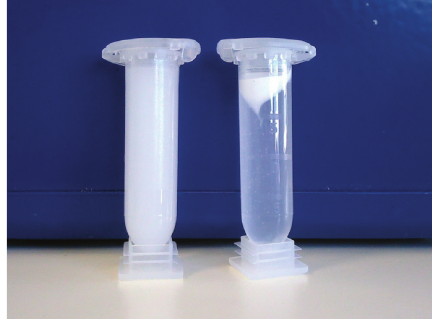
Figure 1: Image of the polyelectrolyte encapsulated octadecane suspension before (left) and after (right)